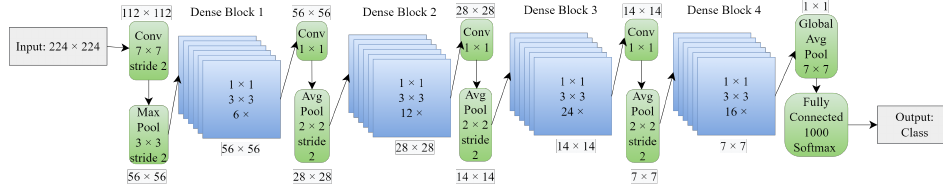
Figure 16. DenseNet